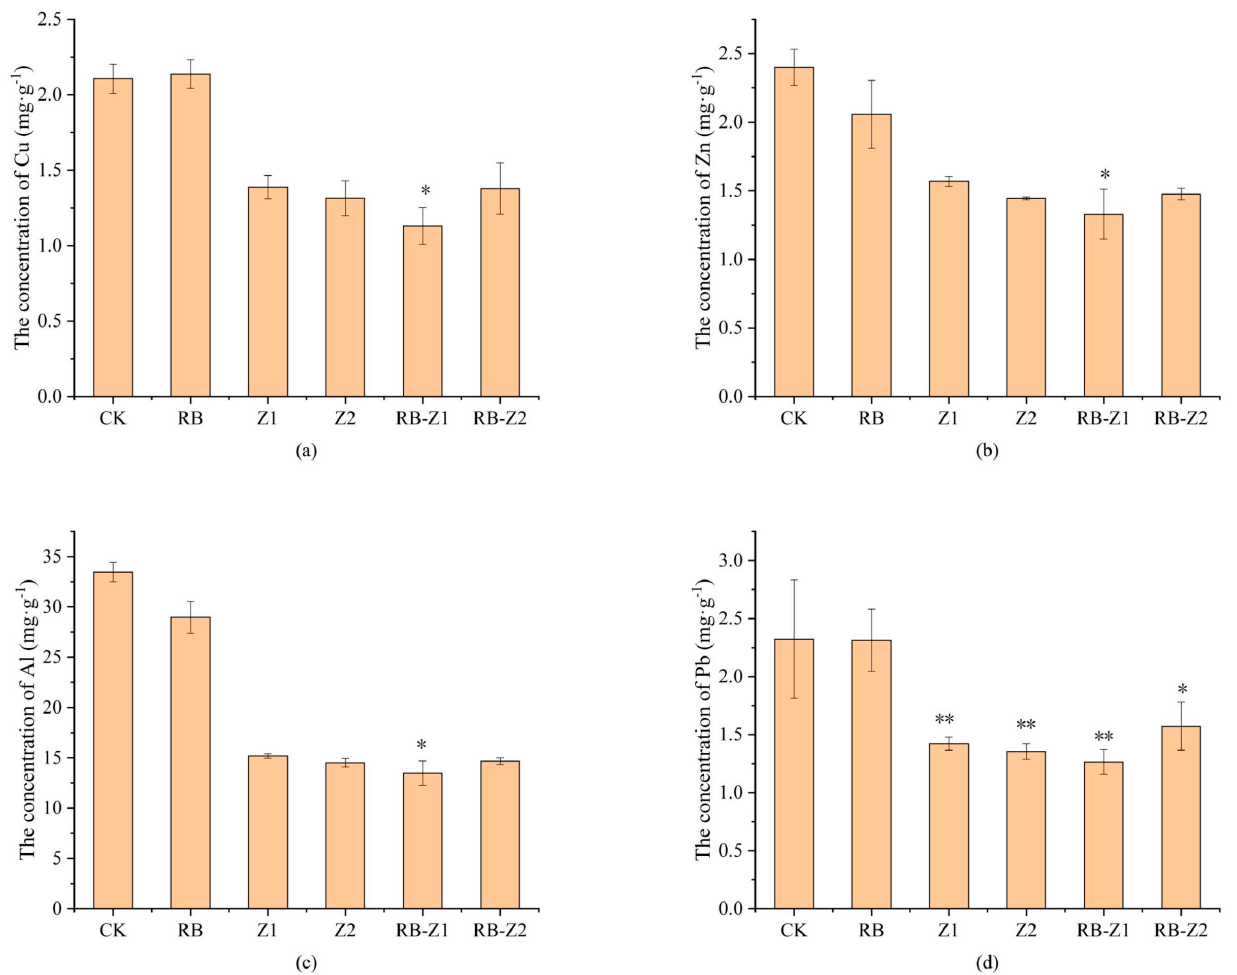
Figure 1. Concentrations of ( a ) Cu, ( b ) Zn, ( c ) Al and ( d ) Pb in rhizosphere soils under different treatments. The data are means ± SD, n = 3. Asterisks (* and **) denote a value significantly greater than the corresponding control value (one asterisk means p < 0.05 and two asterisks indicate p ≤ 0.01).